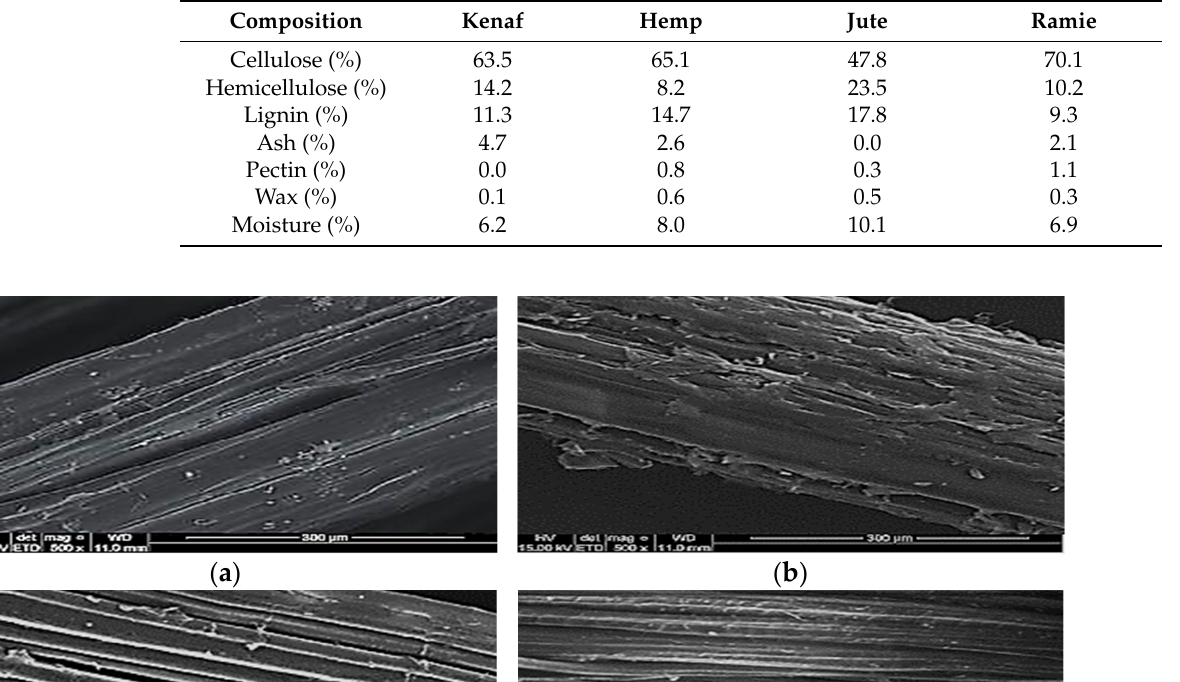
Table 3. Chemical composition of natural lignocellulosic fibers.